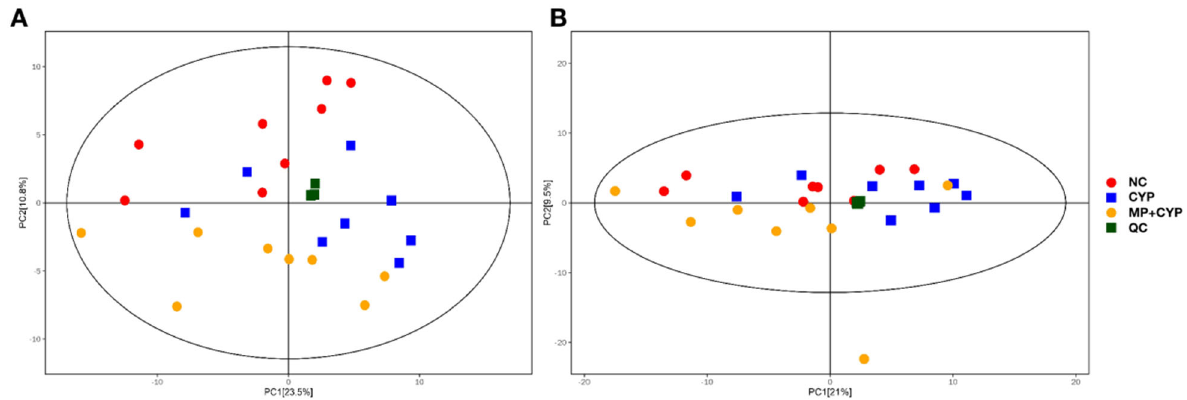
Figure 7. Score scatter plot for PCA model TOTAL with QC. The Normal Control group is shown with red dots, the CYP Model group is shown with blue squares, the MP+CYP group is shown with orange dots, and the QC samples are shown with green squares. ( A ) All samples in ESI+ mode. ( B ) All samples in ESI − mode.